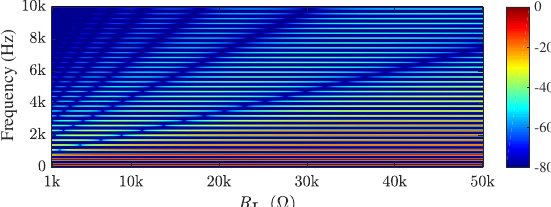
Figure 11. Spectrogram of the Lockhart wavefolder under 150-Hz sinusoidal input for values of R L between 1 and 50k Ω .